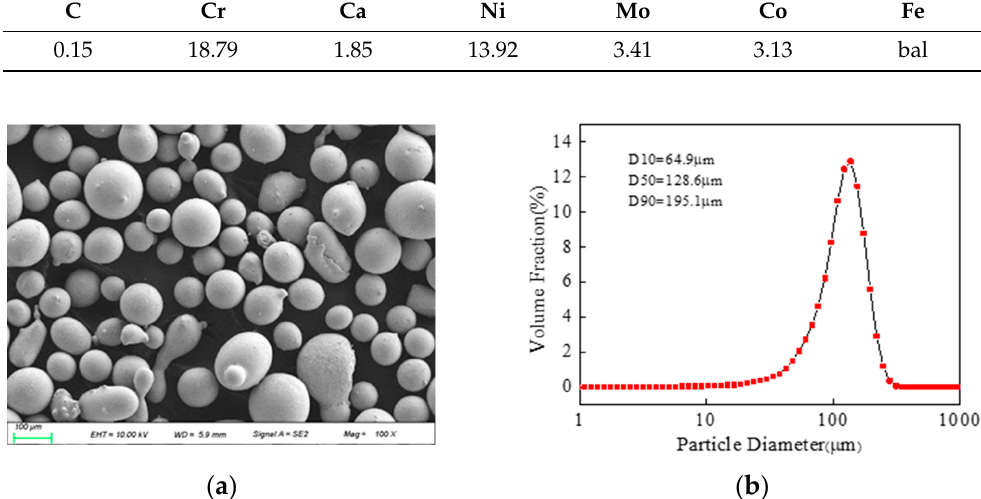
Figure 1. ( a ) SEM morphology of Fe − based alloy powder; ( b ) the diameter distribution of Fe − based powder alloy particle. Table 3. Chemical composition of 27SiMn steel (wt%).